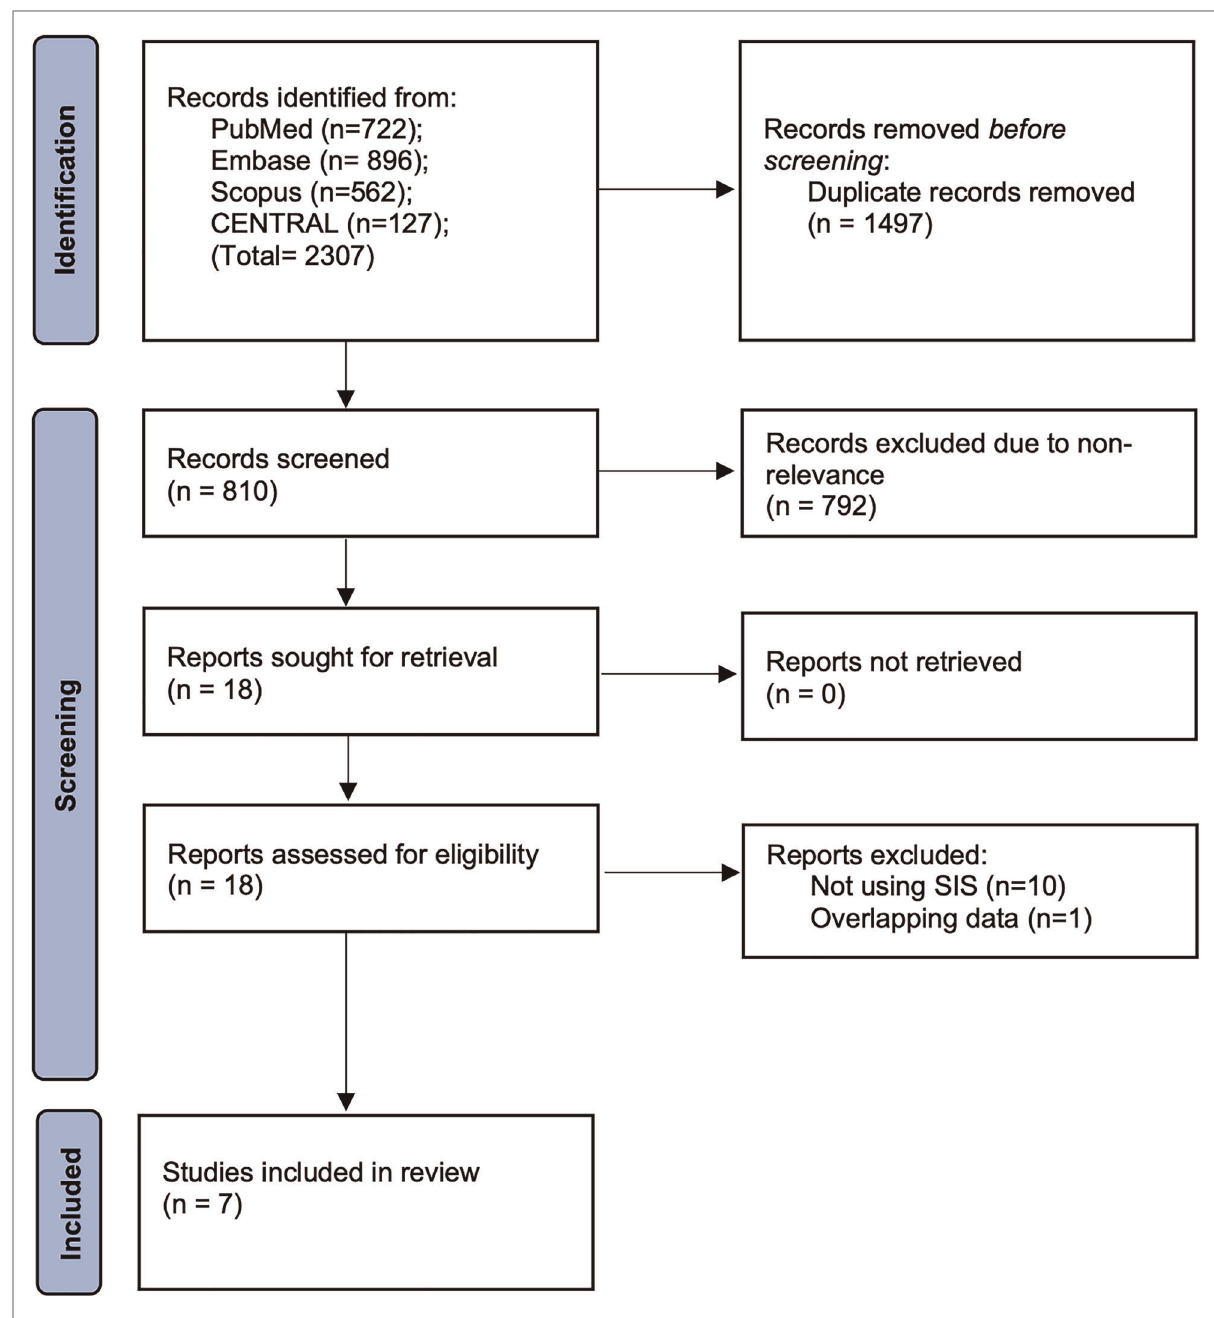
FIGURE 1 PRISMA study fl owchart denoting number of articles at every stage of the inclusion